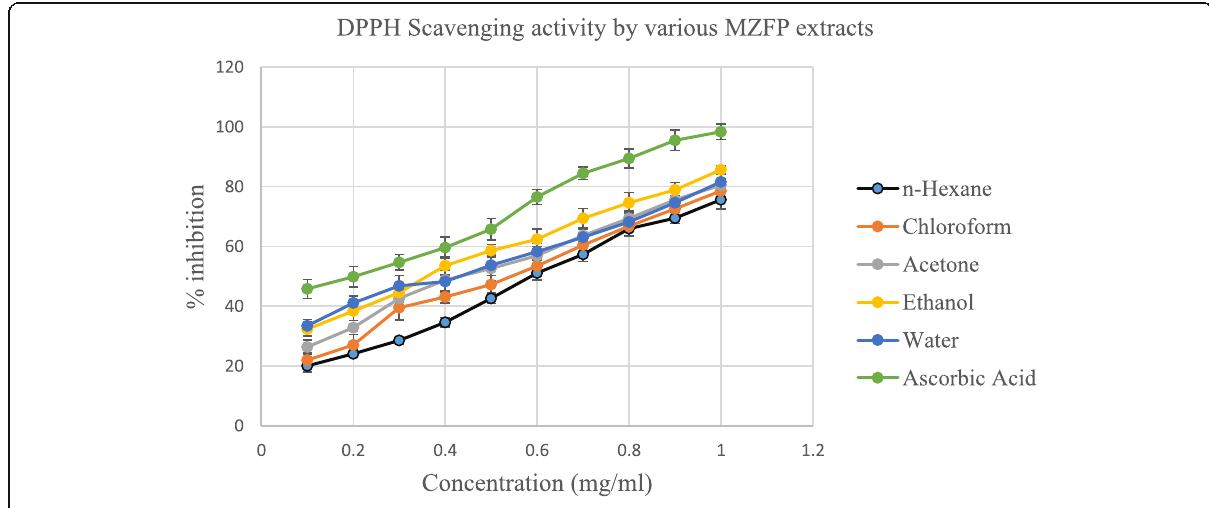
Fig. 1 DPPH scavenging activity by various MZFP extracts. (Values are expressed as mean ± SEM of three determinations)